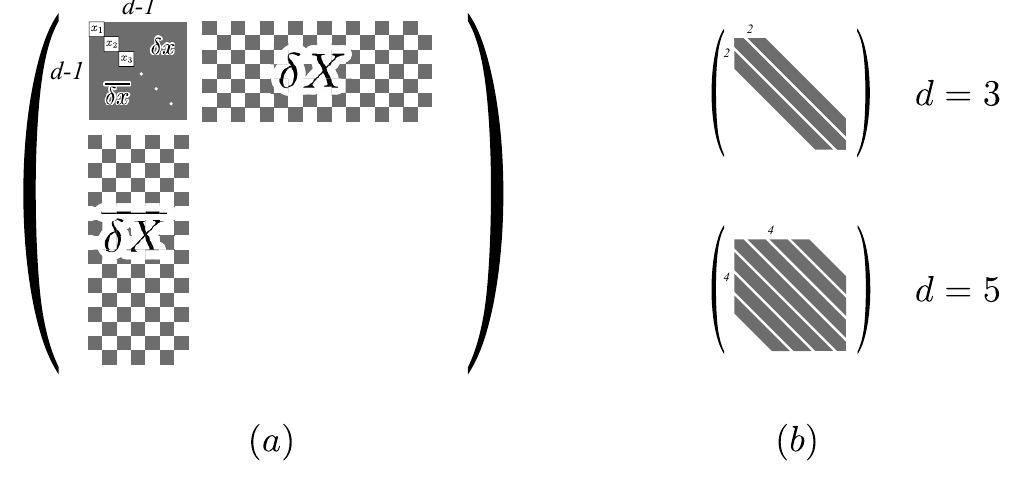
Figure 2 . (a) A shaded sub-block of a matrix that describes a cluster of d (cid:0) 1 D0 branes. The (cid:14)X s refer to the o(cid:11)-diagonal entries spanning clusters; the o(cid:11)-diagonal entries within a cluster are in the shaded block, denoted by (cid:14)x . (b) General structure of non-zero entries in the matrices for di(cid:11)erent space dimensions d . The d (cid:0) 1 labels refer to the number of active columns or rows in the (cid:12)rst row or column, respectively. The shaded diagonals start within the shaded square in (a).